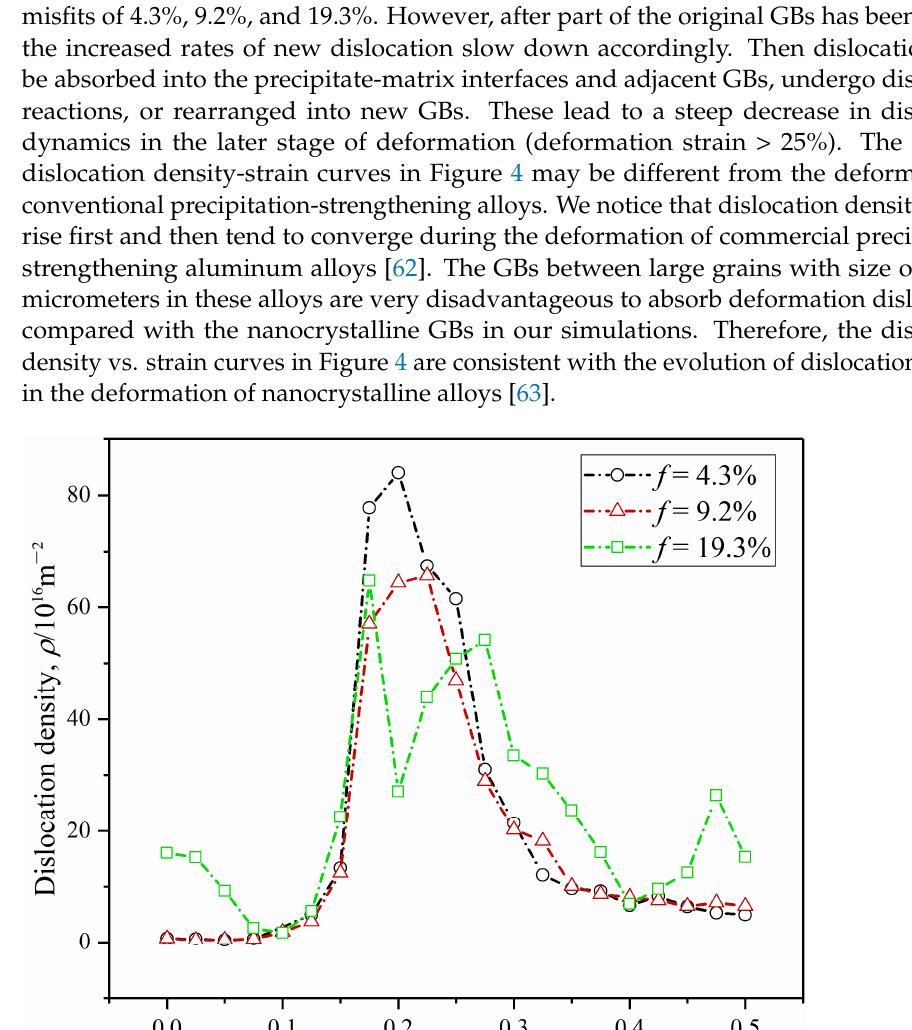
Figure 4. Dislocation density ρ -strain ε curves of the slow deformation process with 𝜀(cid:4662) = 10 − 4 at different lattice misfits of 4.3%, 9.2% and 19.3%.